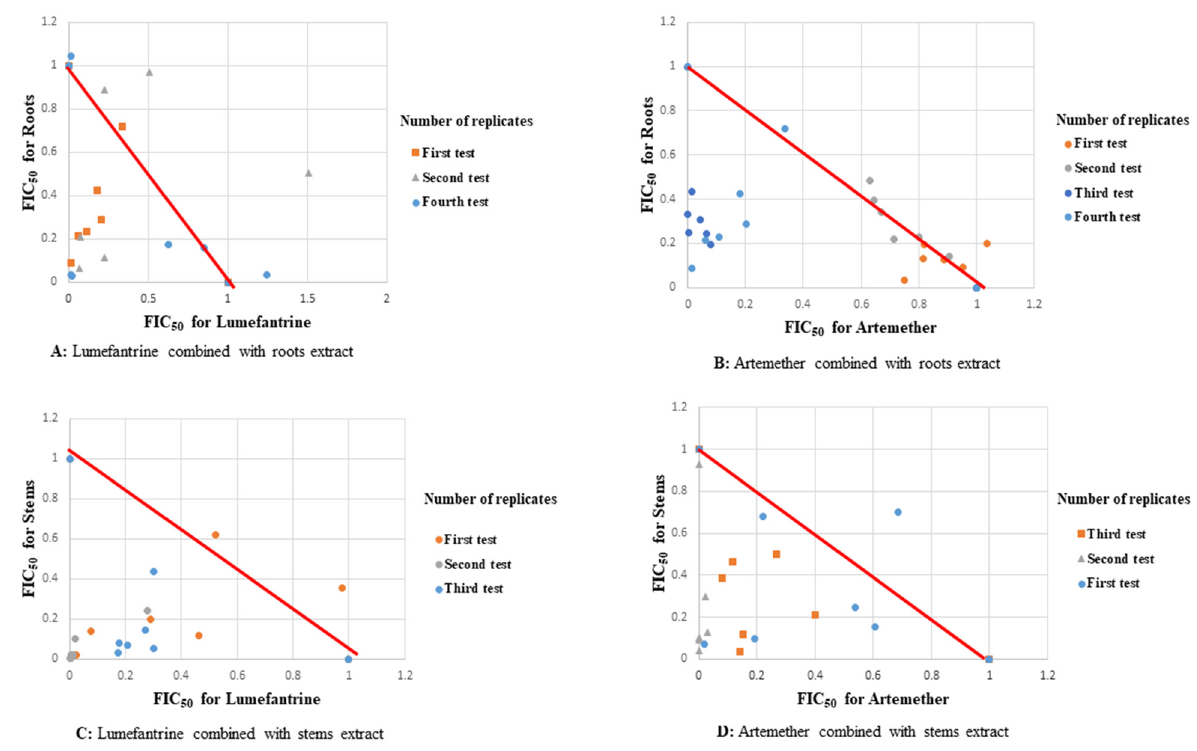
Figure 2. Scatter plots of drugs-extracts combinations against DD2 strain of P. falciparum . All fixed ratios of artemether-roots extract, artemether-stems extract, and lumefantrine- roots extract combinations showed synergism when tested against D6 strain of P. falciparum